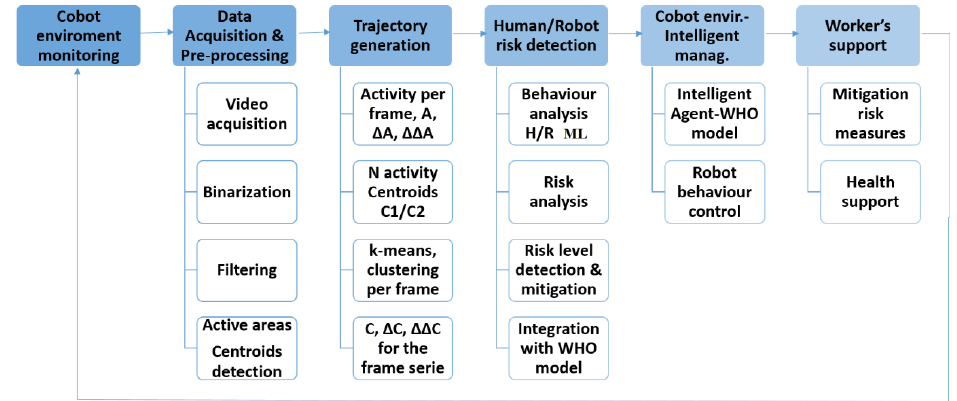
Figure 6. Workflow of the Cobot environment: monitoring and control, showing the steps of image acquisition, pre-processing, data treatment, Human/Robot (HR) behaviour analysis and intelligent management of the environment through WHO models to support the workers.